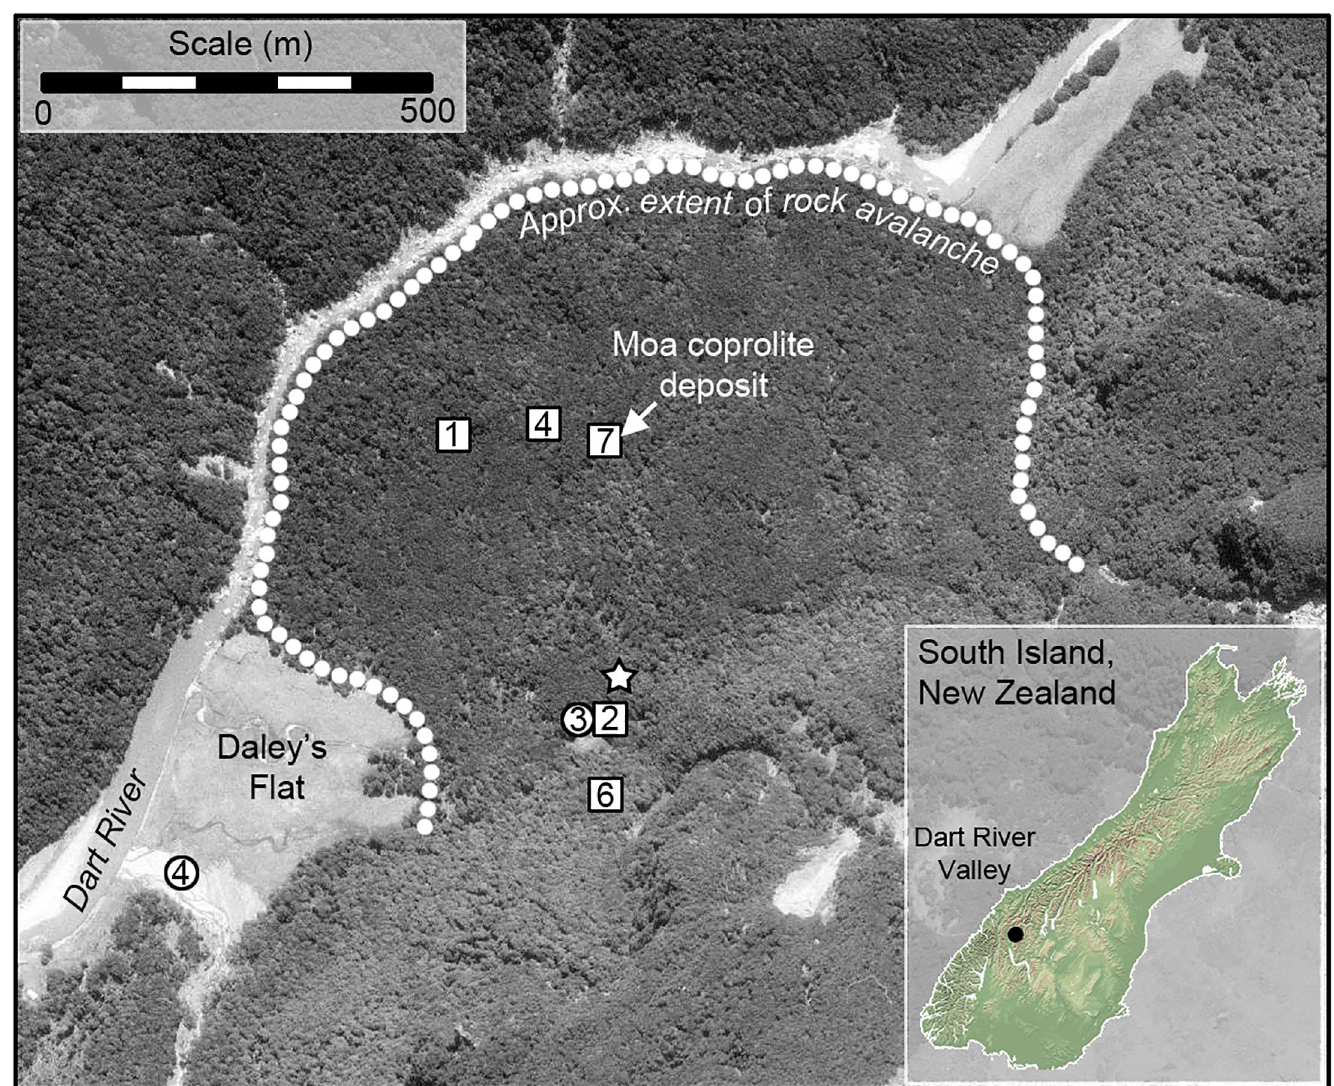
Fig 1. Aerial photograph of Daley’s Flat area, Dart River Valley, New Zealand. The extent of forested rock avalanche deposit and adjacent non-forest habitat are shown, as are the locations and numbers of hare (circles) and deer (squares) pellets collected for this study, and the location of the soil pit from which a pollen stratigraphy was obtained (S2